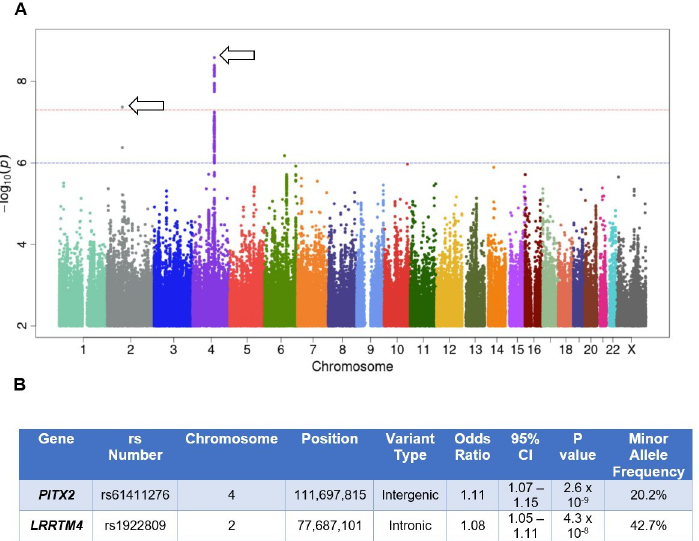
Fig 1. Genome-wide association study analysis for variants associated with cerebrovascular disease in the UK Biobank. (A) Manhattan plot of GWAS results (MAF > 0.5%) for CeVD identified 2 groups of SNPs that were significantly associated with CeVD (B) SNPs with the highest statistical significance from each of the two groups associated with CeVD. For the Manhattan plot, significance is displayed on the y-axis as -log 10 of the p -value, with results ordered along the x-axis by chromosome (each colored bar represents a different chromosome). Arrows represents SNP associated with a genome-wide significance of 5 x 10 − 8 . OR: Odds ratio; PITX2 : Paired like homeodomain 2; LRRTM4 : leucine rich repeat transmembrane neuronal 4; CI: Confidence Interval. https://doi.org/10.1371/journal.pone.0273217.g001 Table ). Of this group, the intergenic SNP rs61411276 (mean allele frequency of 20.2%) was found to be most significantly associated with the outcome, with an odds ratio (OR) of 1.11, 95% confidence interval of 1.07 to 1.15, and a p-value of 2.59 x 10 − 9 . A second SNP (rs1922809) in close proximity to sequences encoding LRRTM4 (leucine rich repeat trans- membrane neuronal 4) was identified. The intronic SNP rs1922809 had an OR of 1.08, 95% confidence interval of 1.05 to 1.11, and a p-value of 4.29 x 10 − 8 . Data from the PheWeb